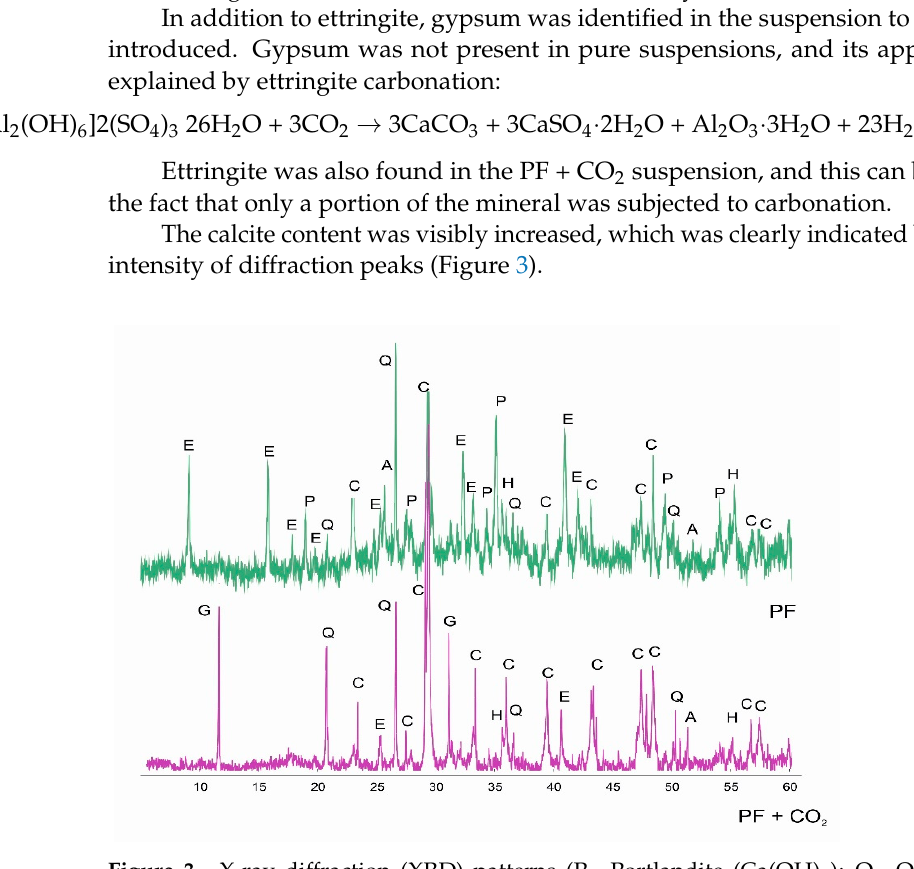
Figure 3. X-ray diffraction (XRD) patterns (P—Portlandite (Ca(OH) 2 ); Q—Quartz (SiO 2 ); E— Ettringite (Ca 6 [Al 2 (OH)6] 2 (SO 4 ) 3 · 26H 2 O); G—Gypsum (CaSO 4 · 2H 2 O); H—Hematite (Fe 2 O 3 ); A— Anhydrite (CaSO 4 )).